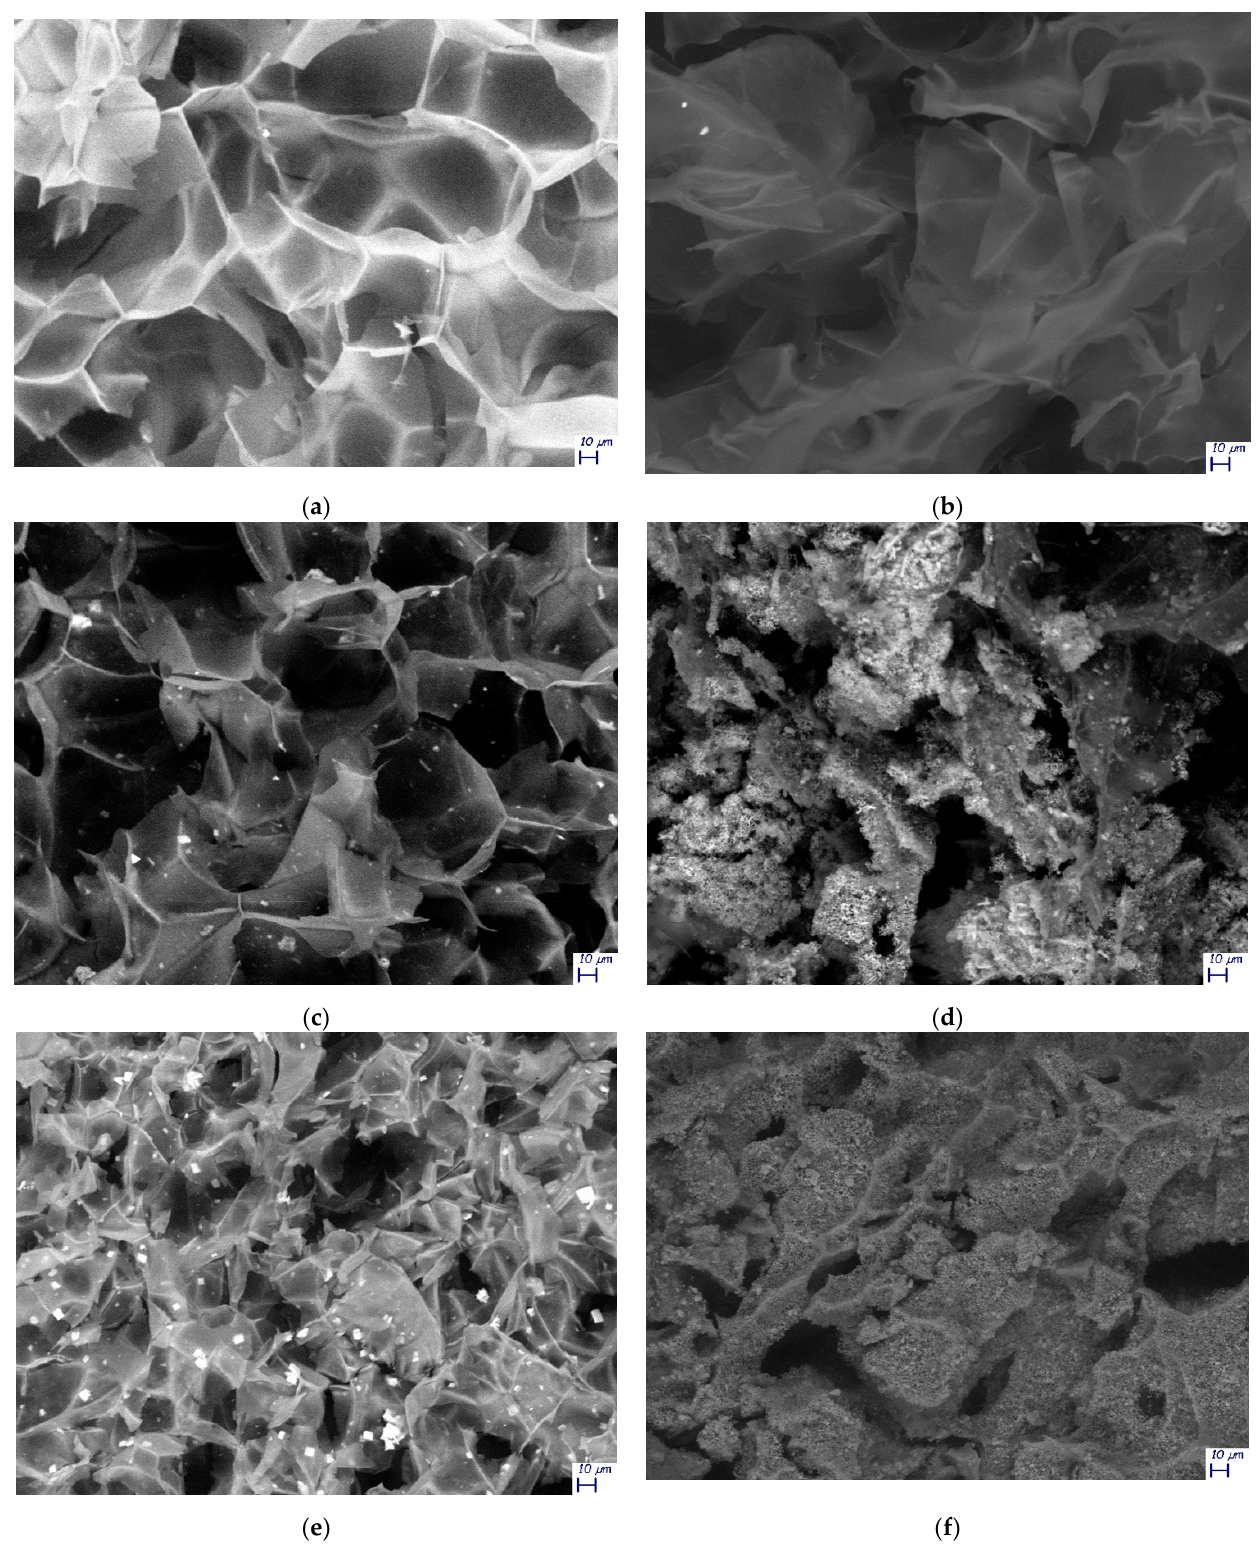
Figure 6. SEM images of: ( a ) TOCNFs before mineralization; ( b ) TOCNFs after mineralization (28 d) and washing step; ( c ) TOCNFs CaP before mineralization; ( d ) TOCNFs CaP after mineralization (28 d) and washing step; ( e ) TOCNFs CaPGO before mineralization; ( f ) TOCNFs CaPGO after mineralization (28 d) and washing step. Scalebar 10 μ m. In Figures S6 and S7 are reported SEM images of mineralized TOCNFs CaP and TOCNFs CaPGO acquired at higher magnification.